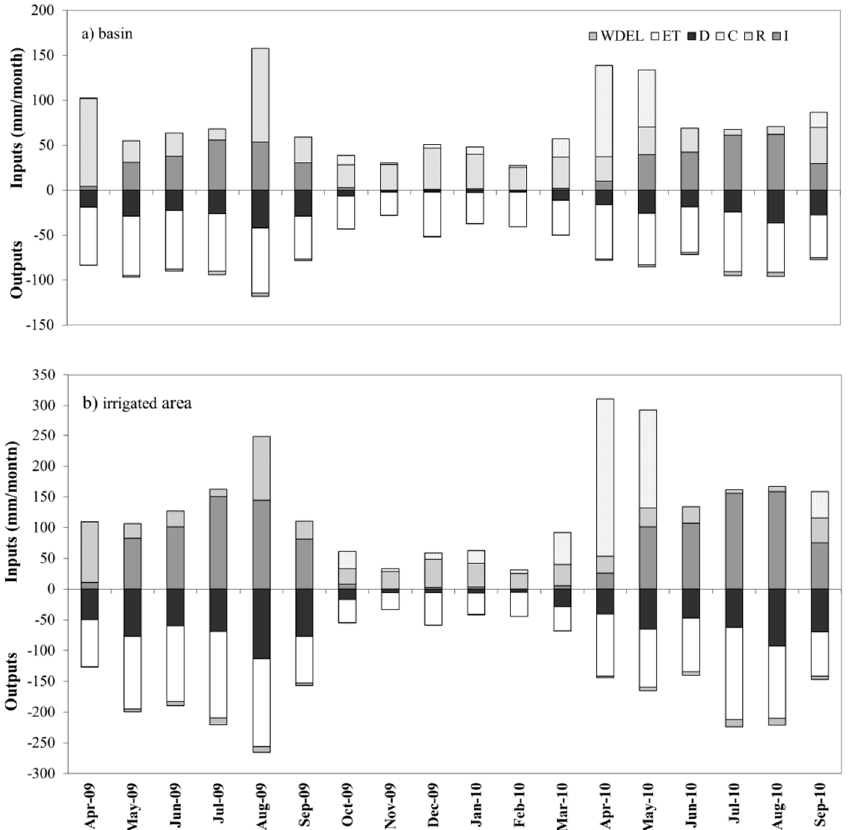
Figure 5. Monthly evolution of inputs (rainfall, R; irrigation, I; Terreu irrigation canal discharge, C) and outputs (evapotranspiration, ET; drainage, D; wind drift and evaporation losses in the sprinkler irrigation system, WDEL) of water in the basin ( a ) and in the irrigated area ( b ) between April 2009 and October 2010.